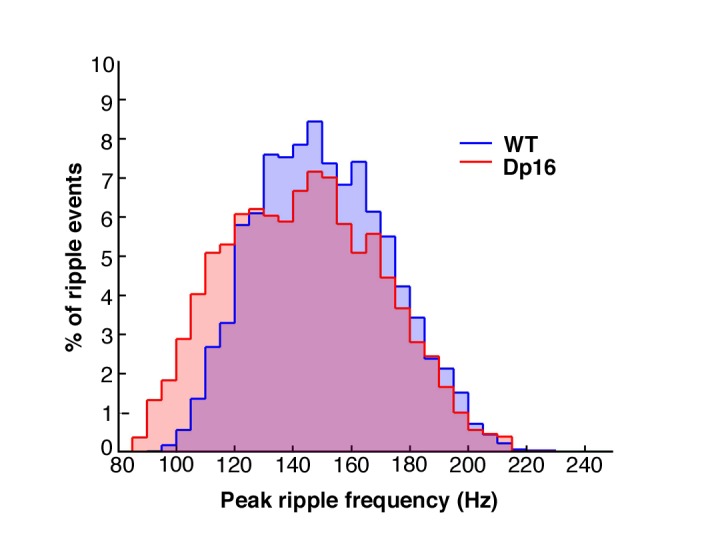
Sharp wave ripple peak frequency was not significantly affected in Dp(16)1Yey mice.The population distribution of sharp wave ripples was plotted according to their intrinsic peak frequency for all WT (blue; N = 5, n = 4541 ripples) and Dp(16)1Yey (red; N = 6, n = 6034 ripples) mice. A mild shift toward events of lower frequencies was observed in Dp(16)1Yey mice, but this did not reach the level of significance (Kolmogorov-Smirnov test for normality: p=0.6403, k = 0.1714).